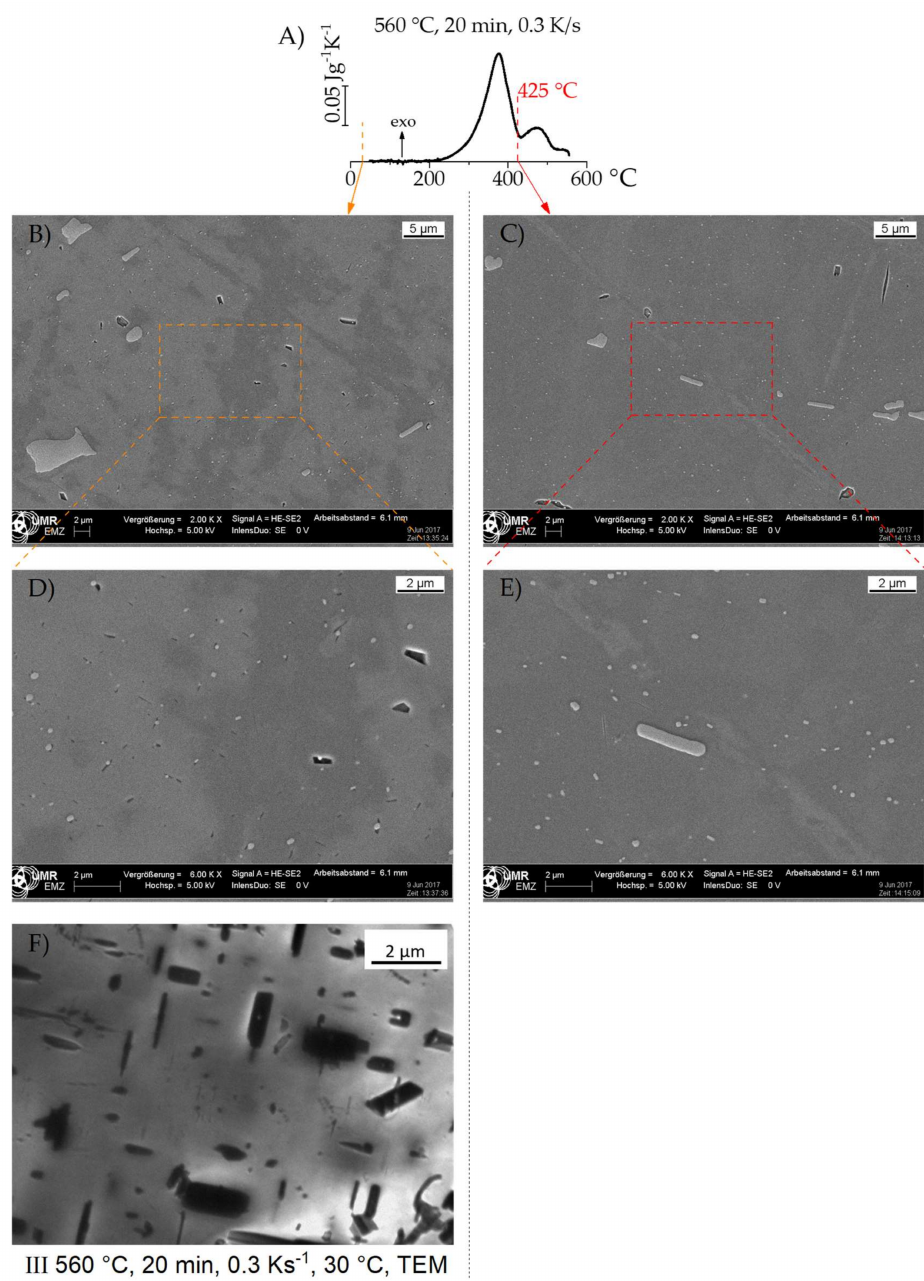
Figure 10. ( A ) DSC cooling curve after solution-annealing at 560 ◦ C, a 20 min soaking time, and a cooling rate of 0.3 K/s, and associated ( B – E ) SEM and ( F ) transmission electron microscopy (TEM) images at different